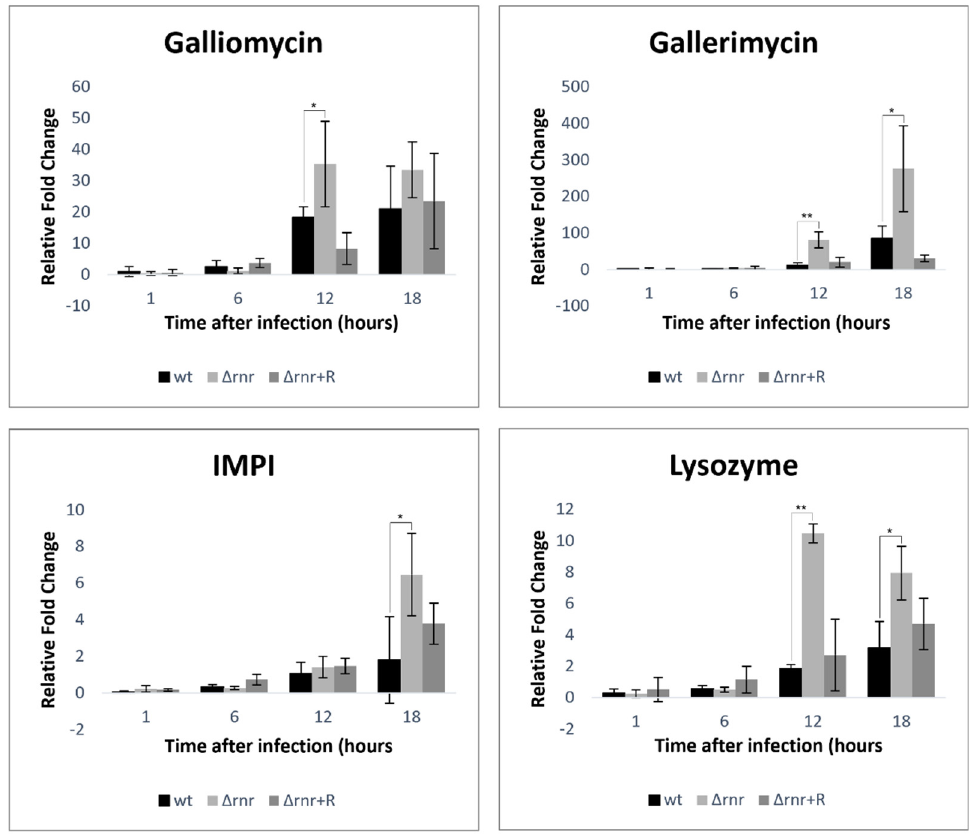
Figure 2. Immunogenic response of G. mellonella during infection with S. pneumoniae TIGR4 and derivatives. Expression levels of the immune-responsive genes of G. mellonella were measured at 1, 6, 12, and 18 h postinfection with 5 × 10 6 bacteria/larva of the S. pneumoniae TIGR4 wild type (wt), RNase R mutant ( ∆ rnr ), ∆ rnr expressing RNase R in trans ( ∆ rnr +R), and PBS (as a control). The transcriptional levels of gallerimycin, galliomycin, IMPI, and lysozyme were determined by quantitative RT-PCR analysis and compared between the larvae infected with the wild type (wt) and mutant strains ( ∆ rnr and ∆ rnr +R). Results were normalized to the expression of the housekeeping gene actin and are shown relative to the corresponding expression levels in noninfected larvae injected with PBS. These data are representative of three independent experiments (* p < 0.05; ** p < 0.01).